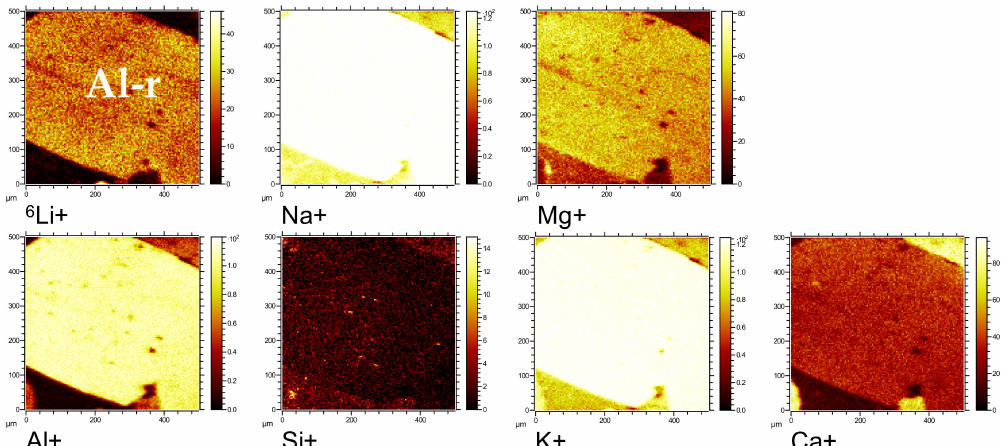
Figure 5. Details of the lateral intensity distributions of selected positive isotope-resolved secondary ion signals of an aluminum-rich phase (Al-r) containing Li, Na, Mg and